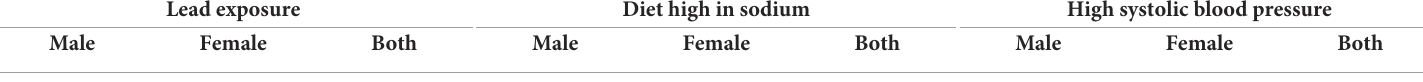
TABLE 6 Attributable risks of ASDR in